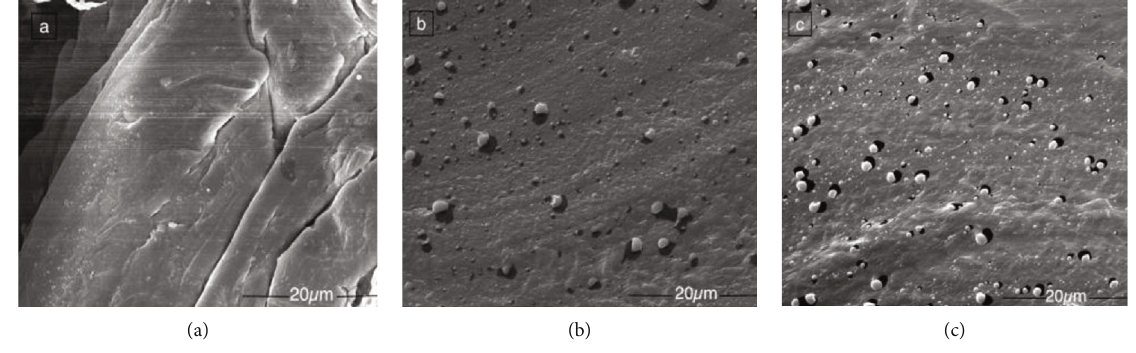
Figure 1: SEM image of (a) PE, (b) PP-g-PHMG/PE-30, and (c) PP-g-PHMG/PE-40.